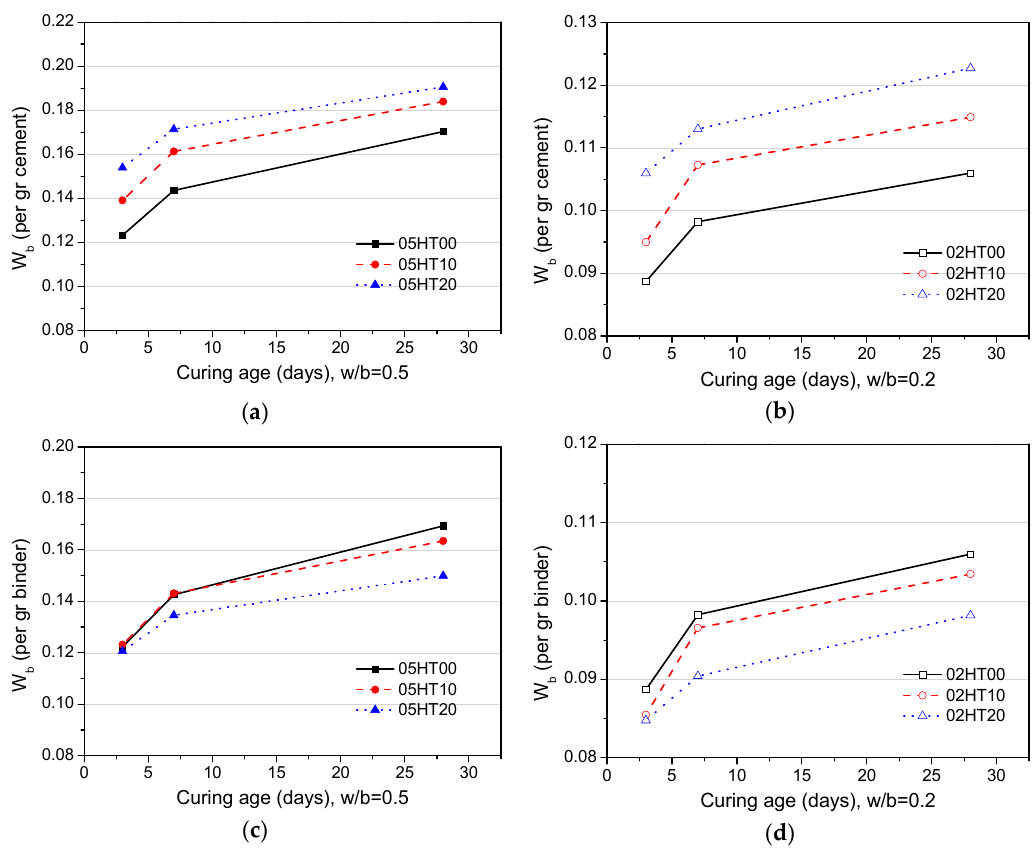
Figure 10. W b content per gram of cement when ( a ) w/b = 0.5 and ( b ) w/b = 0.2. W b content per gram of binder when ( c ) w/b = 0.5 and ( d ) w/b = 0.2.